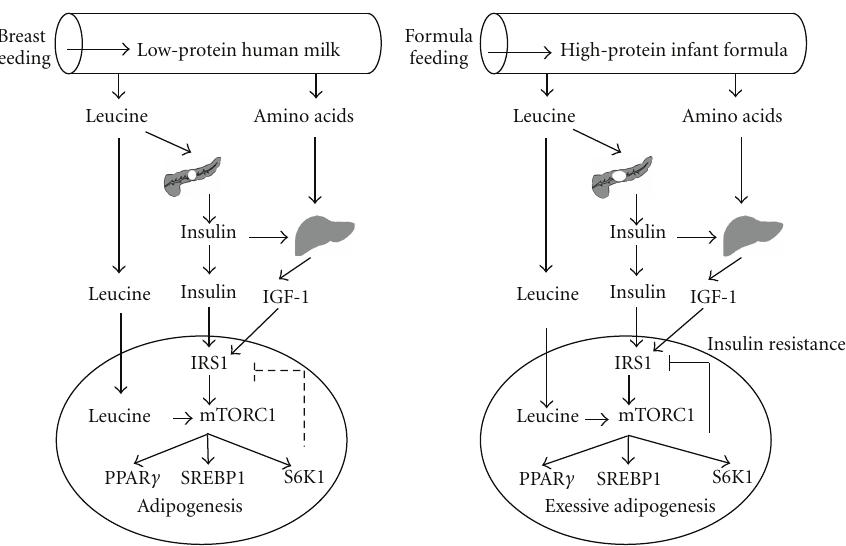
Figure 4: Comparison between physiologic human milk-mediated mTORC1 signalling and exaggerated adipogenic mTORC1 signalling by feeding leucine-rich infant formula (abbreviations see Figure